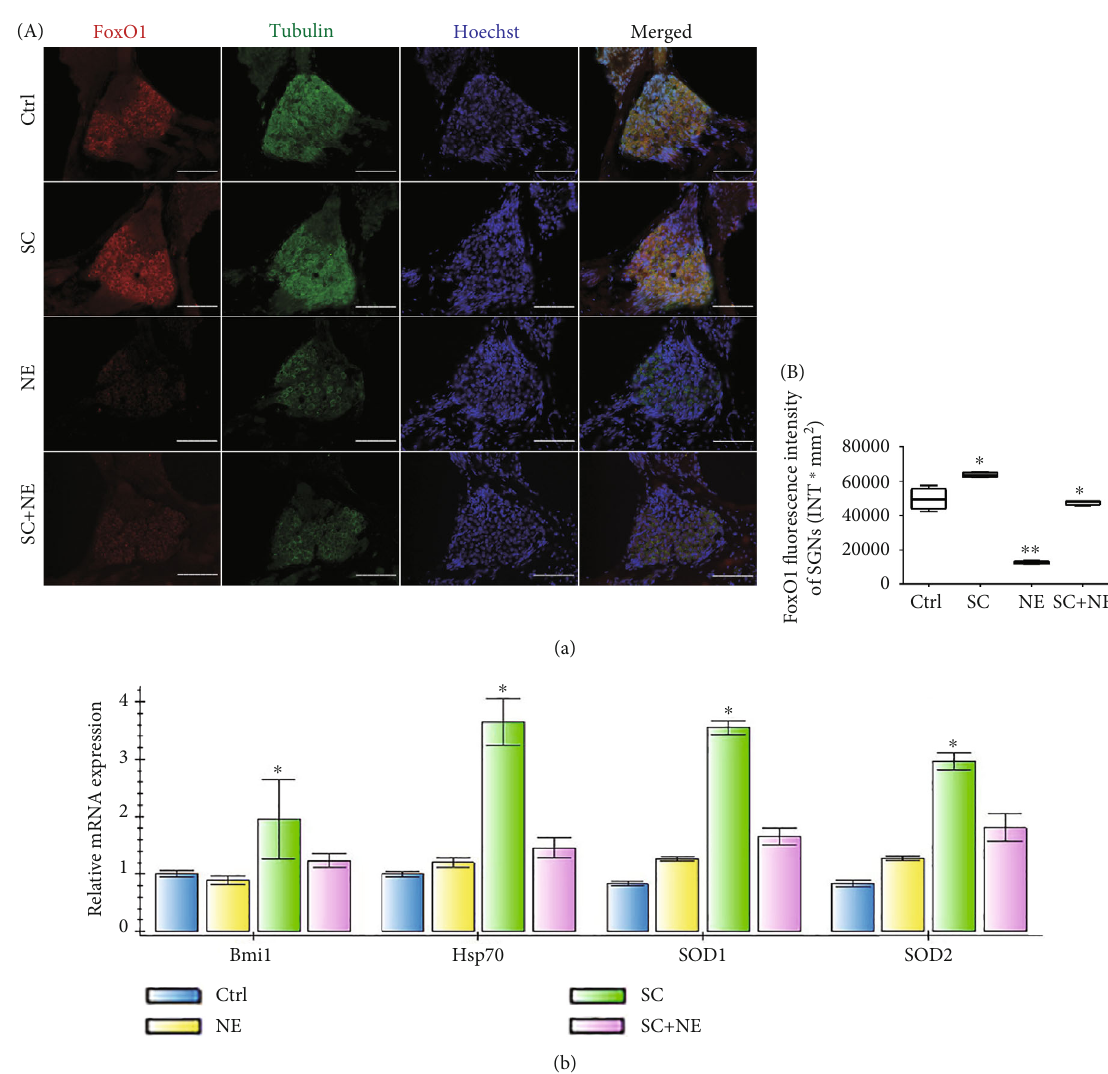
Figure 4: FoxO1 protein and Hsp70, Bmi1, SOD1, and SOD2 mRNA expressions of SGNs after sound conditioning and acute noise exposure. Distributions and expressions of FoxO1 (a) protein were detected with the immune- fl uorescence assay in the Ctrl and SC groups as well as the NE and SC+NE groups (A), while the quantity of these protein expressions was analyzed by fl uorescence intensity (B). FoxO1 (red) and tubulin (green) as SGN marker were, respectively, labeled with fl uorescent secondary antibody, and nuclei (blue) were labeled with Hoechst. Scale bars represent 100 μ m (a). Statistical analysis of the results presented in (B) was performed with one-way ANOVA (FoxO1: F = 155 : 3 , P < 0 : 0001 ), followed by Newman-Keuls ’ post hoc test ( ∗ P < 0 : 05 , ∗∗ P < 0 : 05 ; n = 6 pictures from 3 animals/group). Furthermore, values are means ± SD . Relative mRNA expressions of Bmi1, Hsp70, SOD1, and SOD2 were determined by quantitative RT-PCR (b). β -Actin RNA level was used as an endogenous control. Values are means ± SD ( n = 6 animals/group). ∗ P < 0 : 05 vs. control